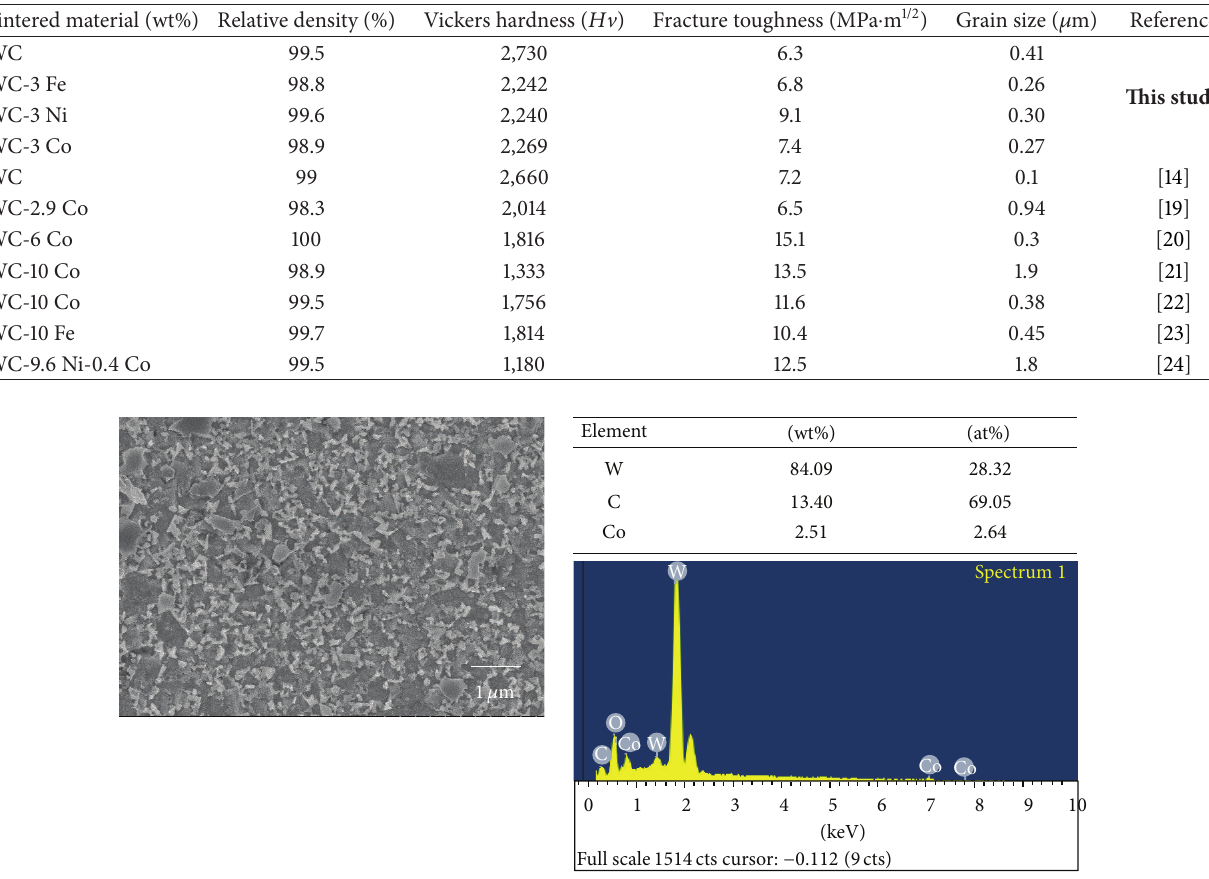
Figure 6: EDX analysis result of WC-3wt% Co sintered